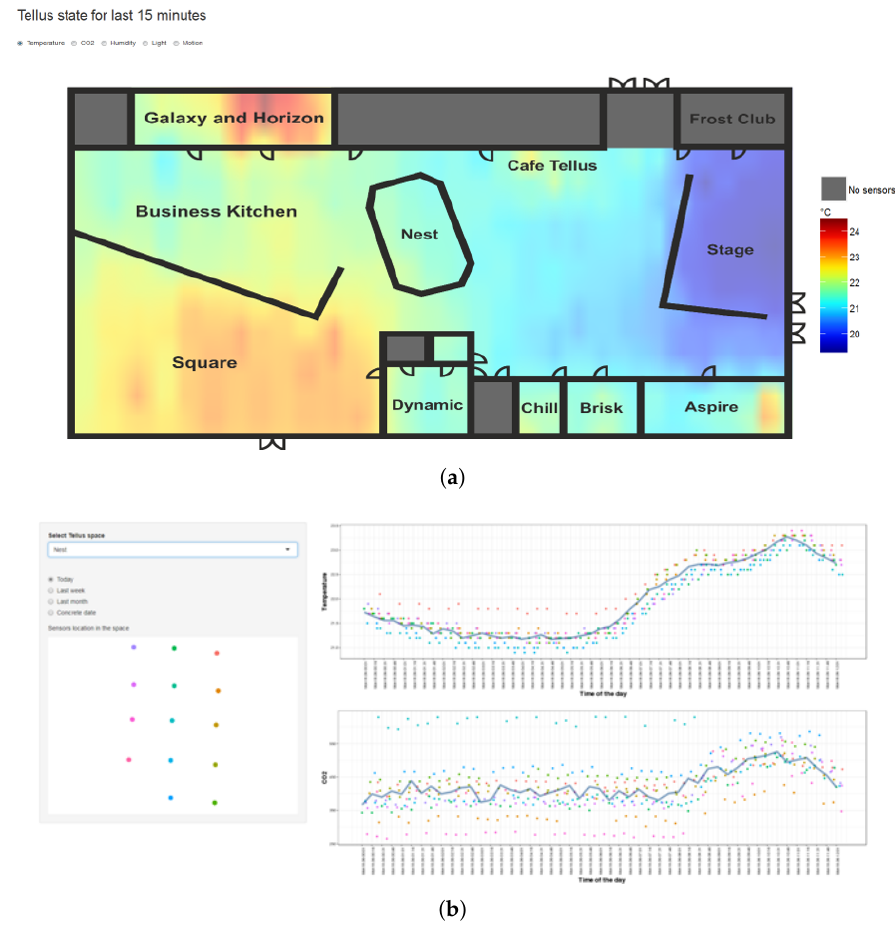
Figure 11. Visualization of Tellus space: ( a ) Heatmap visualization of current state (Temperature parameter selected); and ( b ) basic graphs for the selected space and